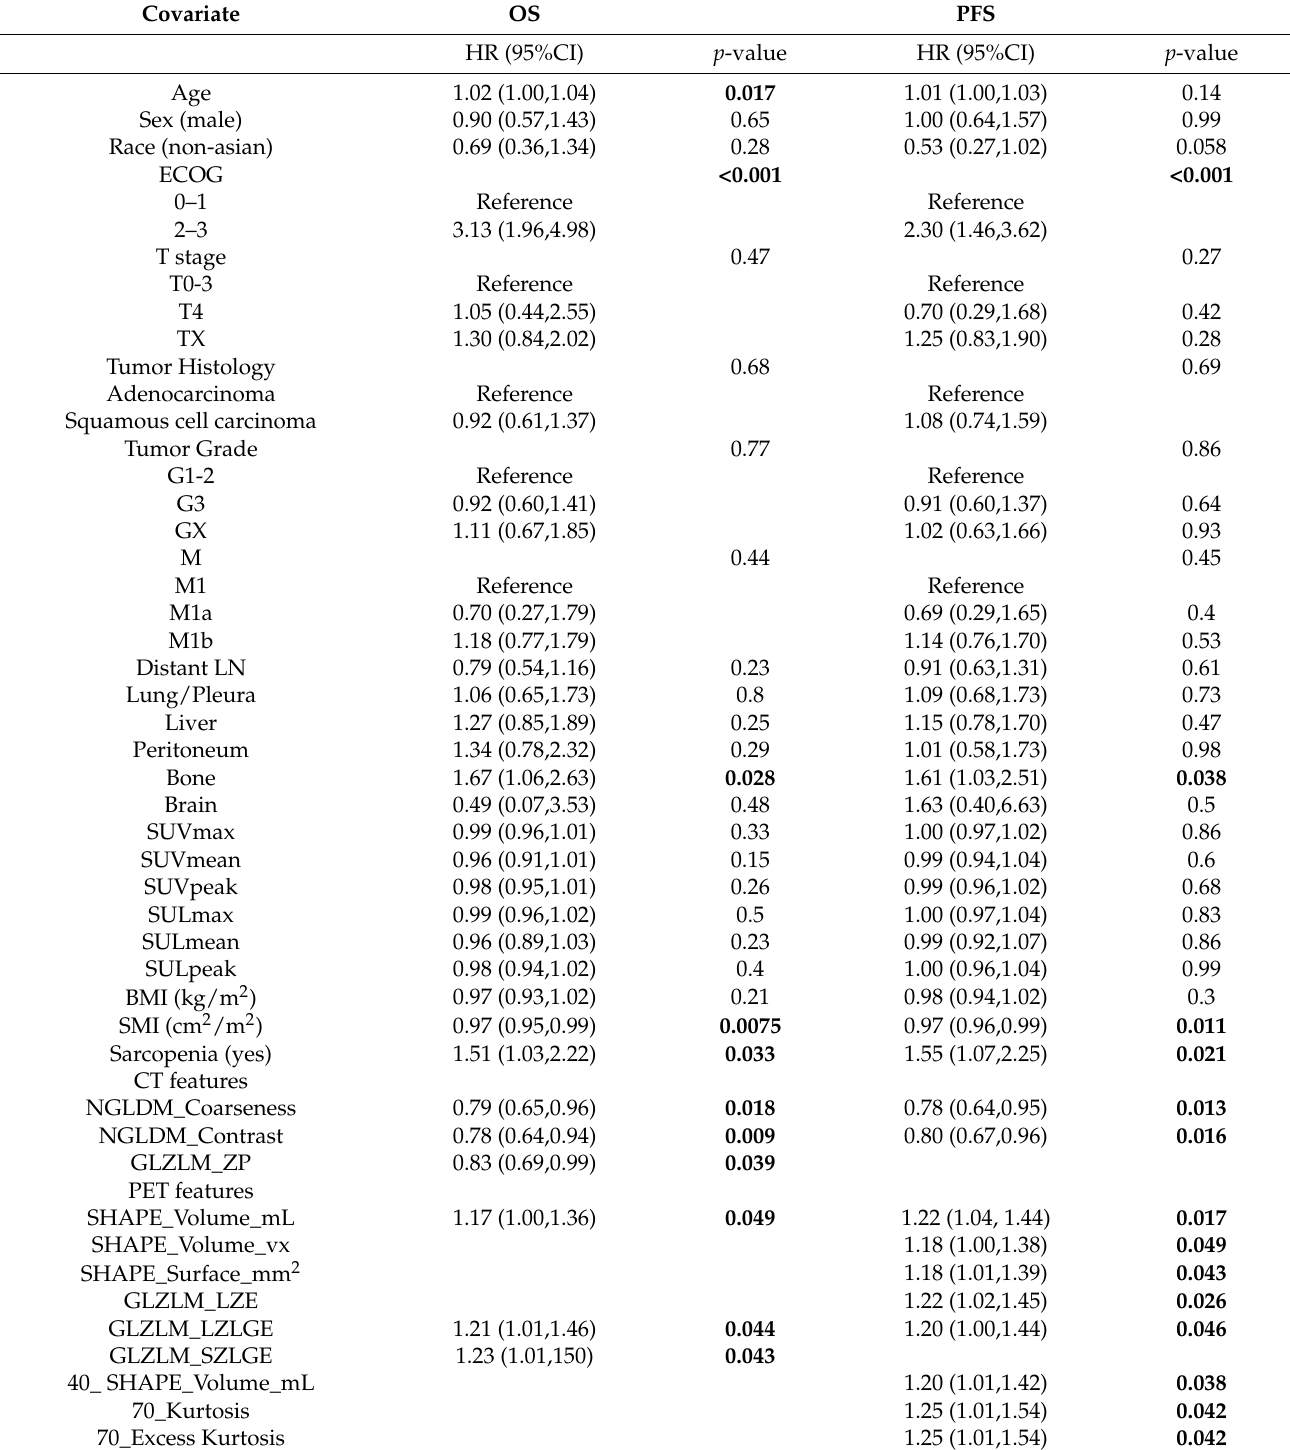
Table 2. Univariable Cox regression analysis for OS and PFS in the overall